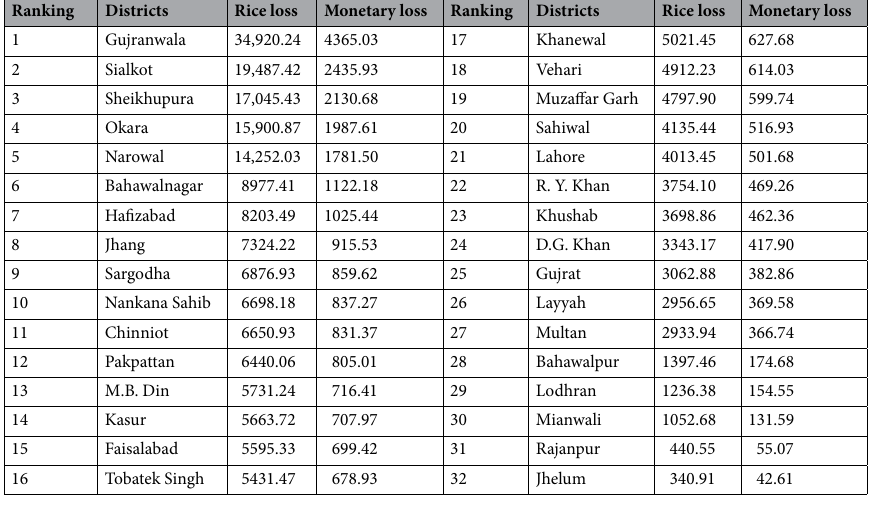
Table 7. Climate induced monetary and yield loss ranking of districts of the